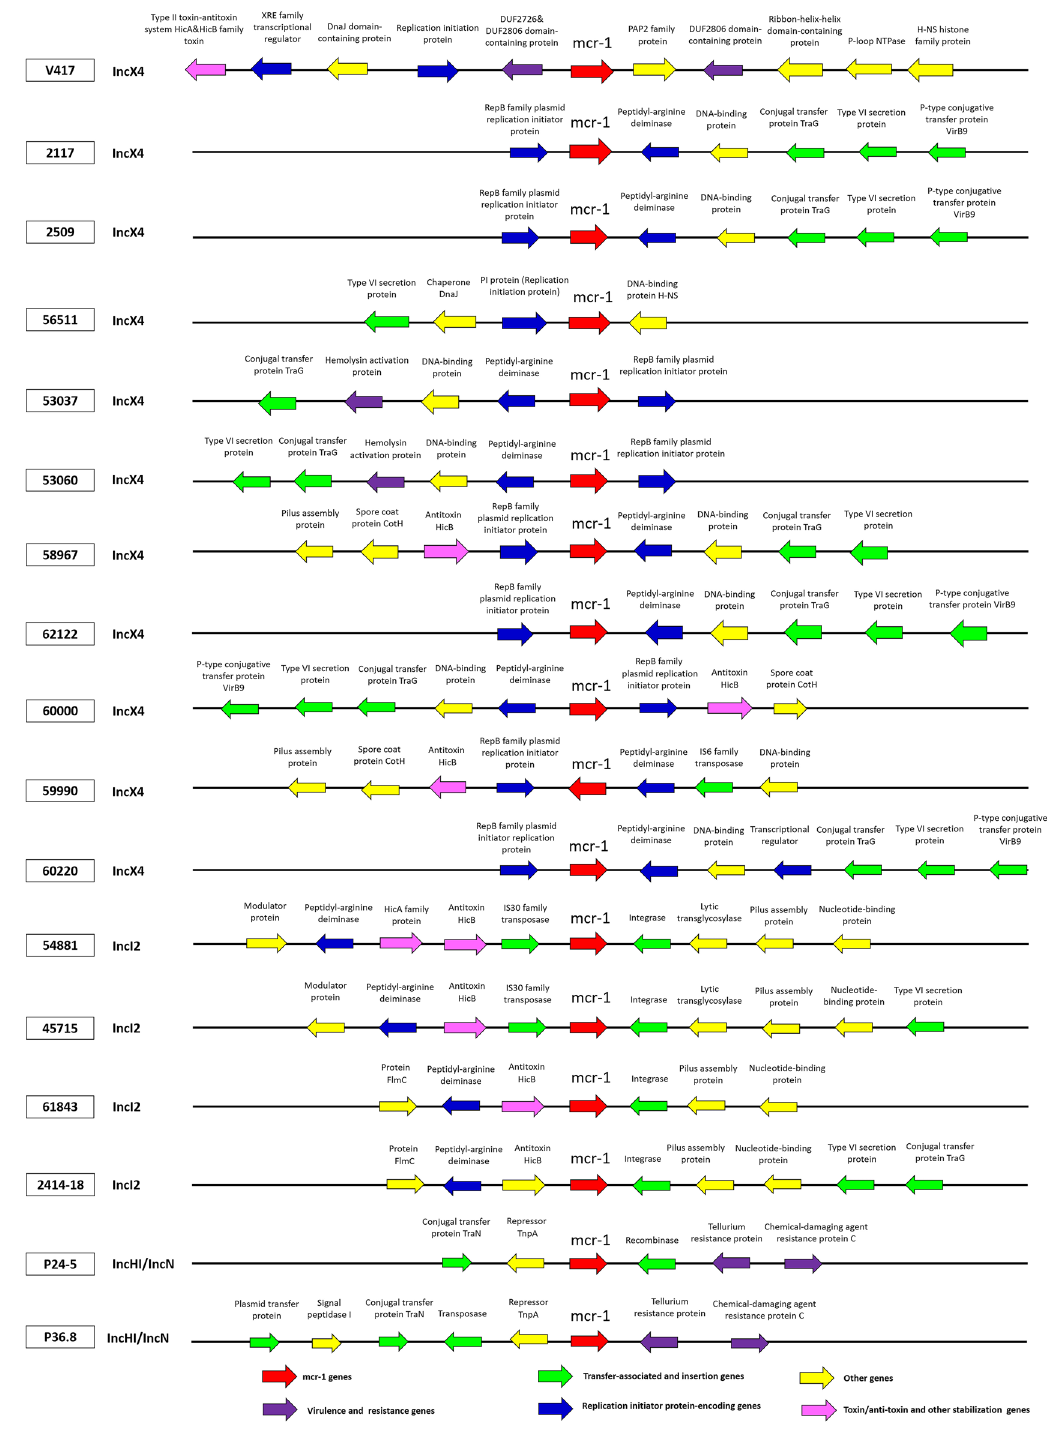
Figure 6. Schematic partial representation of coding sequences or genes surrounding mcr-1 among 17 mcr - carrying plasmids in E. coli and K. pneumoniae . The coding sequences are represented by arrows pointing toward their respective